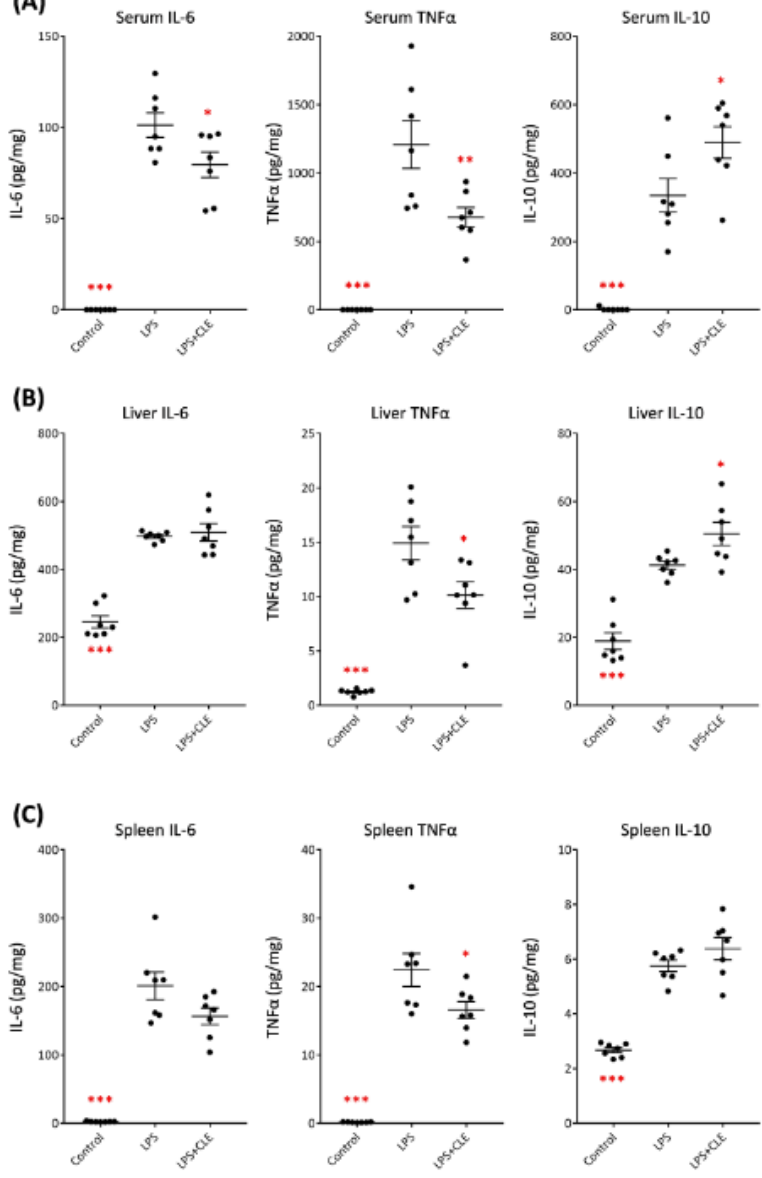
Figure 7. Effect of an aqueous extract from leaves of Citrus unshiu (CLE) on the cytokine levels in LPS-induced systemic inflammation mice. Control and LPS groups received water for 7 consecutive days, while LPS + CLE group received CLE (300 mg/kg). LPS and LPS + CLE groups were intraperitoneally injected with LPS (5 mg/kg) 2 h after the last oral administration on day 7, whereas control group was injected with 200 µL of PBS. Two hours later, all mice were anesthetized, and the cytokine levels in the blood, liver, and spleen were measured by ELISA. Data are represented as mean ± SEM ( n = 7). * p < 0.05, ** p < 0.01, or *** p < 0.001 against LPS by Dunnett’s test. Serum ( A ), liver ( B ), spleen ( C ).